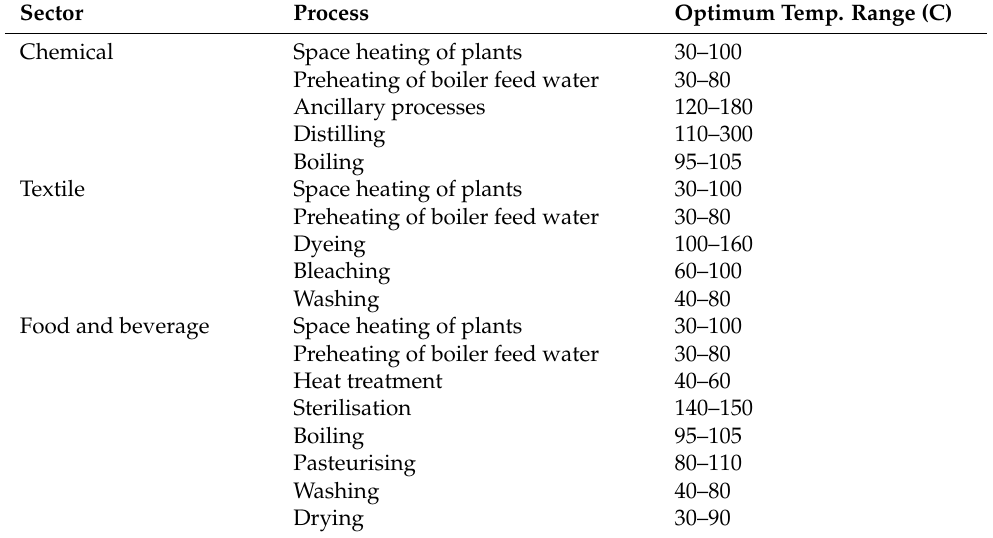
Table 1. Process temperatures in solar-based industrial applications